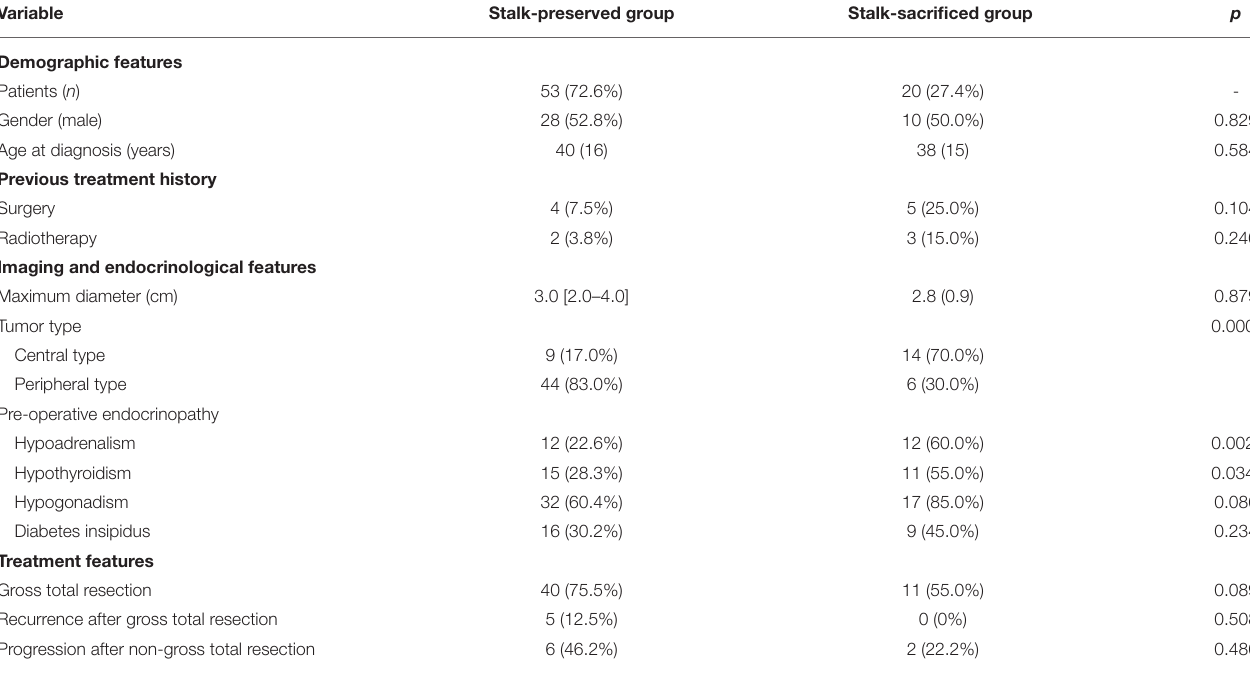
TABLE 4 | Clinical characteristics between patients with pituitary stalk preservation and sacrifice.